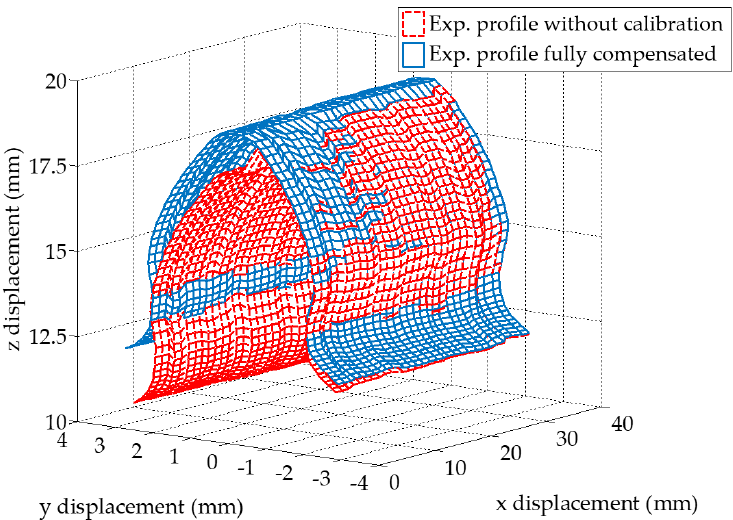
Figure 10. Reconstructed gear profile based on the proposed method. Note the uncalibrated profile is distorted and deformed from the calibrated one. Also, each vertex in the mesh represents one data point. The actual data set is two orders of magnitude denser than that in the plot, the sparsification of data is for clear illustration.